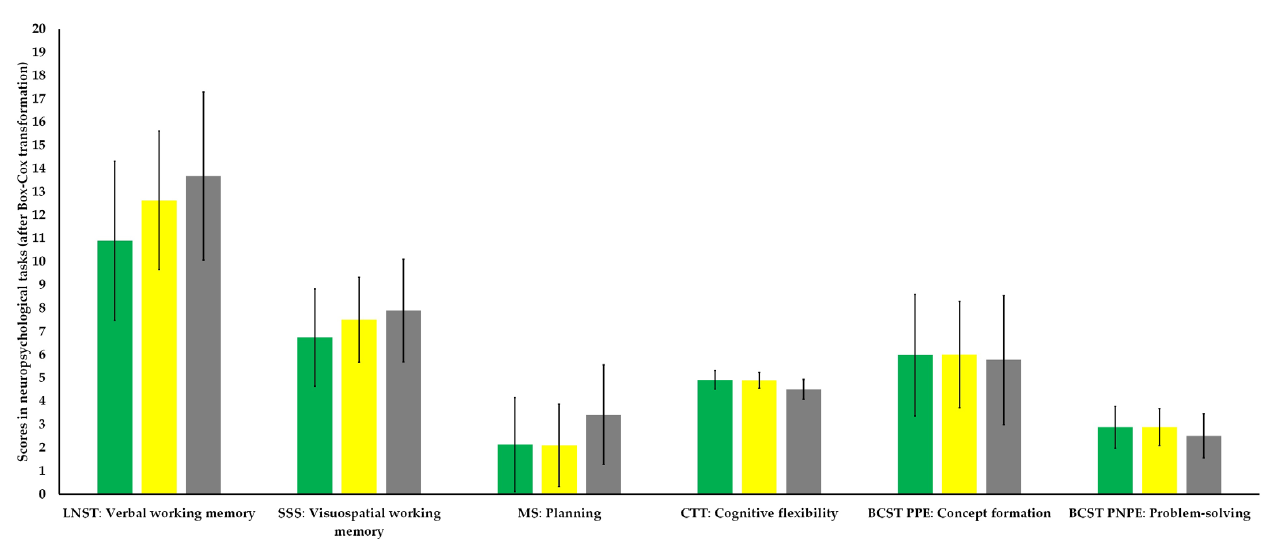
Figure 1. Comparison of executive function profiles between all three groups (scatter bars present SD). BCST = Berg Card Sorting Test; CTT = Color Trail Test; LNST = Letter Number Span Test; MS = Mazes Subtest; SSS = Spatial Span Subtest.